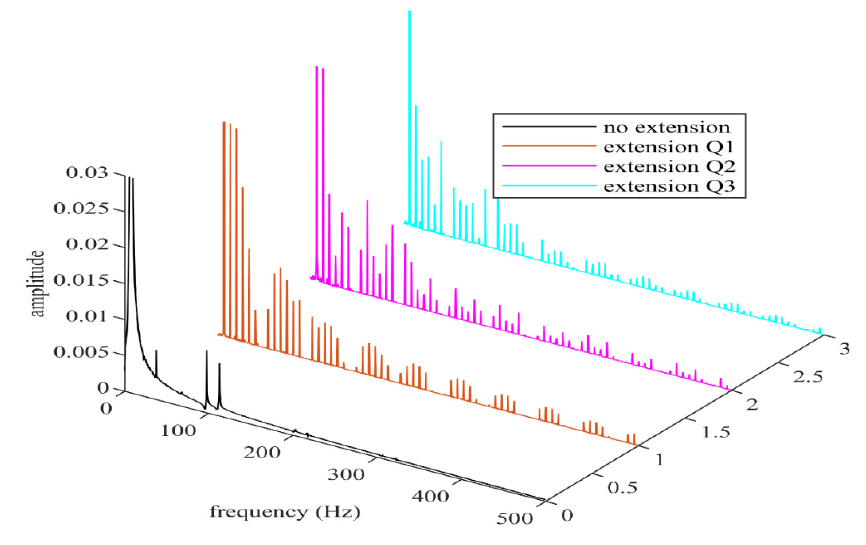
Figure 20. FFT of the current waveforms at 420 rpm using different extension